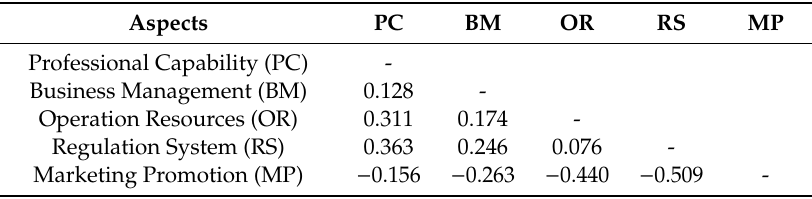
Table 10. The net influence matrix for industrial